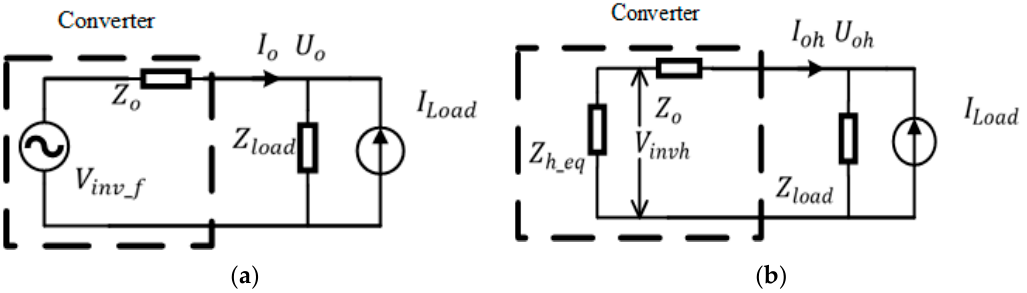
Figure 5. The equivalent topology two-terminal circuit of the converter. ( a ) The equivalent circuit of the inverter in fundamental frequency; ( b ) The equivalent circuit of the inverter in harmonic frequency.